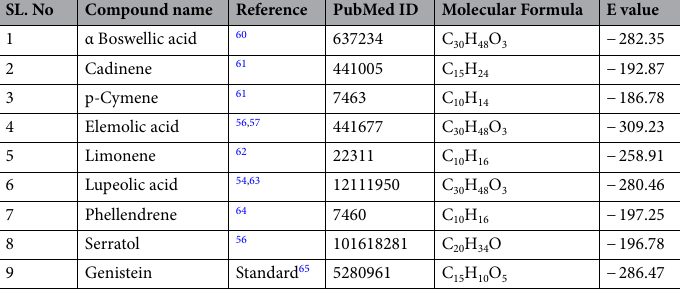
Table 1. Energy values of molecules from B. serrata to bind GIIA (PDB id: 1POE).